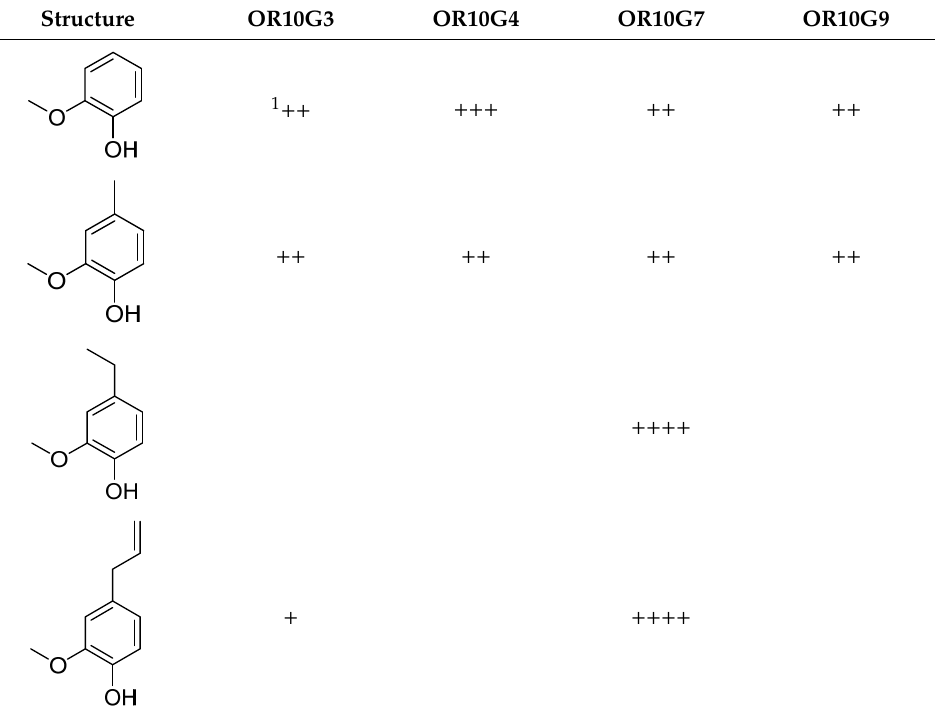
Table 1. Structure–activity relationship of OR10G receptors [19].